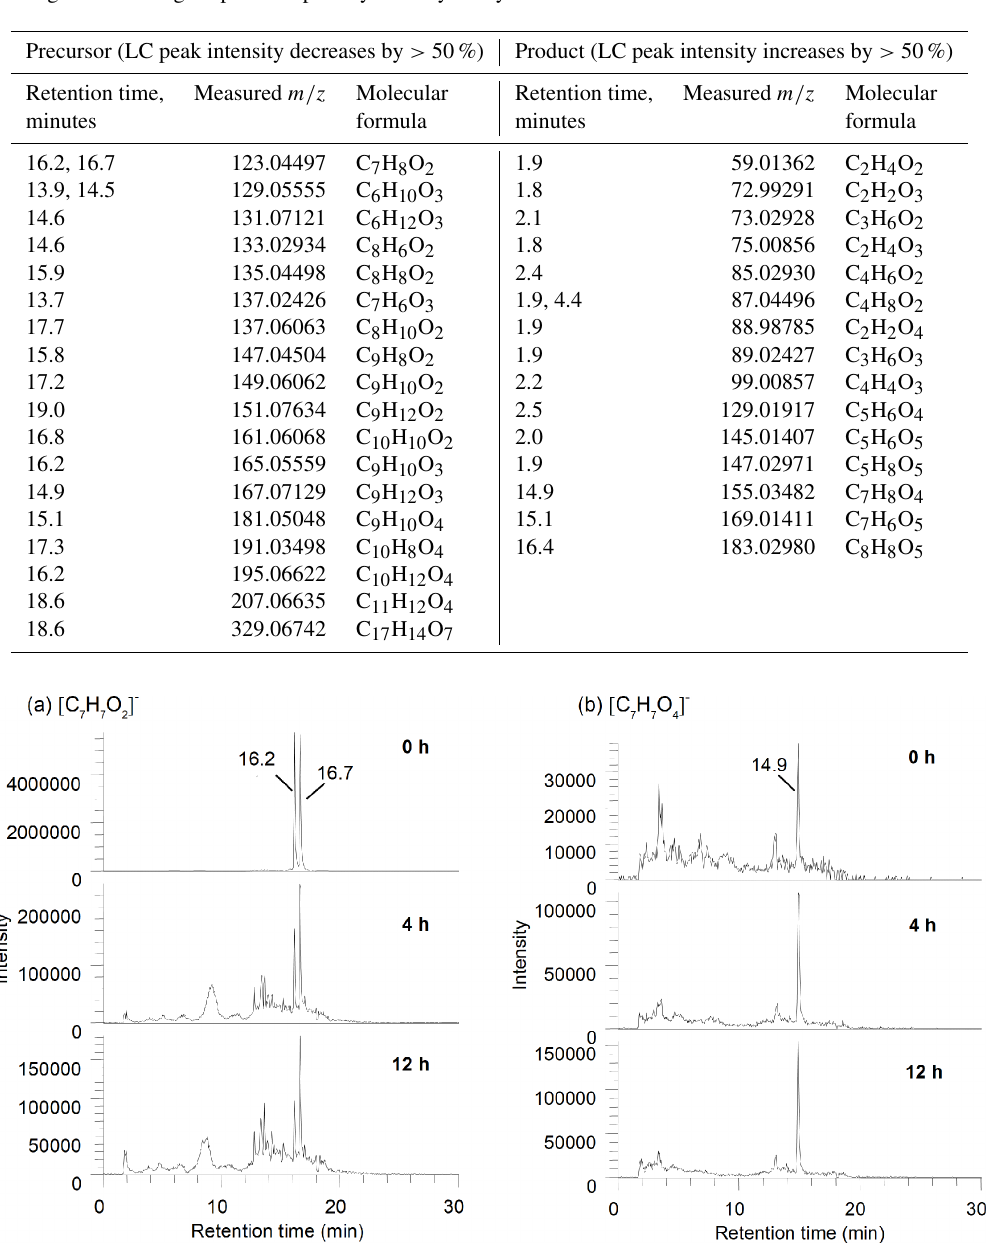
Figure 5. Extracted LC chromatograms from HBDM-1 of (a) [ C 7 H 7 O 2 ] − and (b) [ C 7 H 7 O 4 ] − at different photolytic stages of 0, 4, and